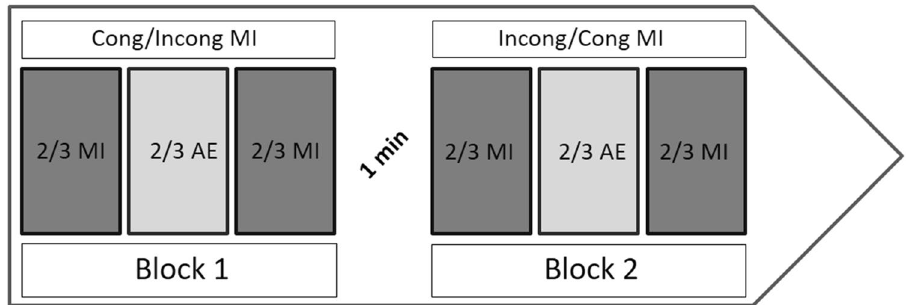
Figure 4. Time course of the MI and AE trials, for each task. Participants performed two blocks of trials, each being composed of two or three MI trials (if the time difference between the first and the second trial was higher than 10%, a third trial was carried out), followed by two or three AE trials, followed again by two or three MI trials. During the first block, participants had to imagine the task in one of two body positions, either congruent (Cong) or incongruent (Incong) with the action. During the second block, they had to imagine the task while adopting the other body position. The order of the blocks was counterbalanced across participants, and a 1 min rest period separated the two